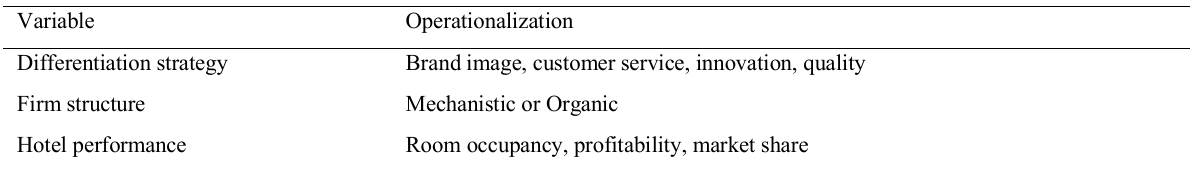
Table 1: Operationalization of